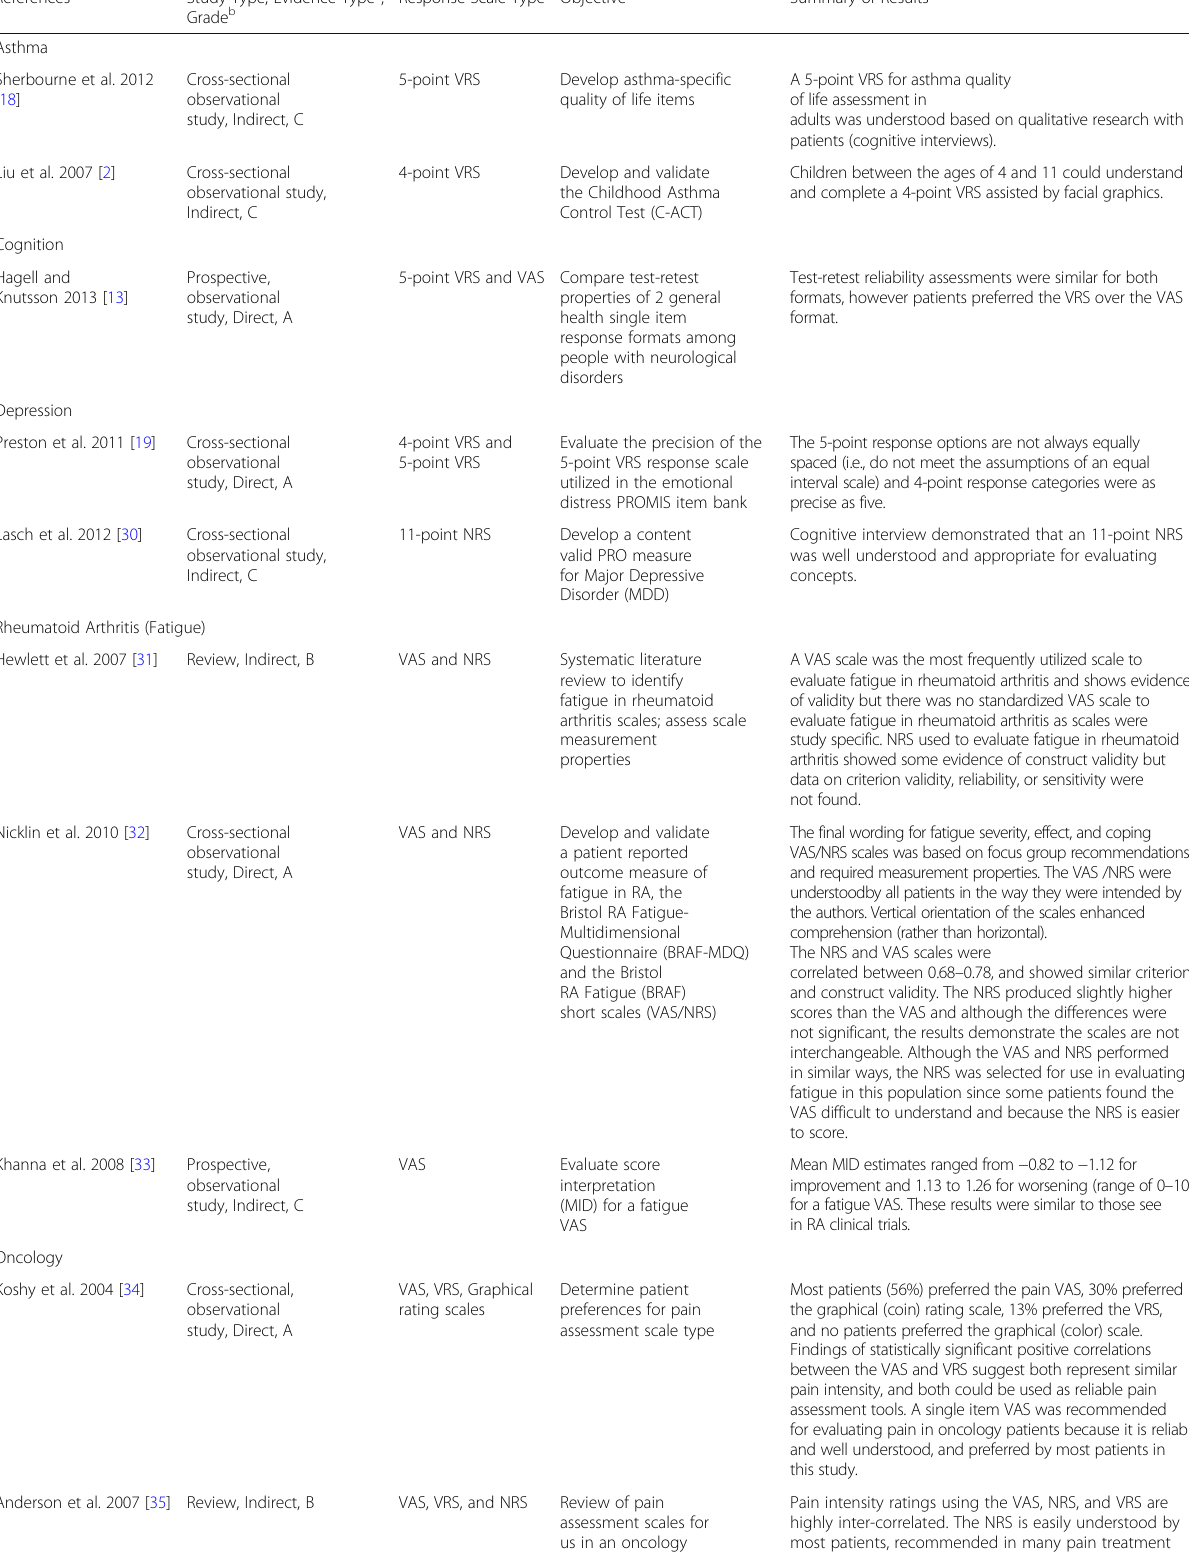
Table 3 Key studies that support response scale selection used in PRO instruments based on select therapeutic